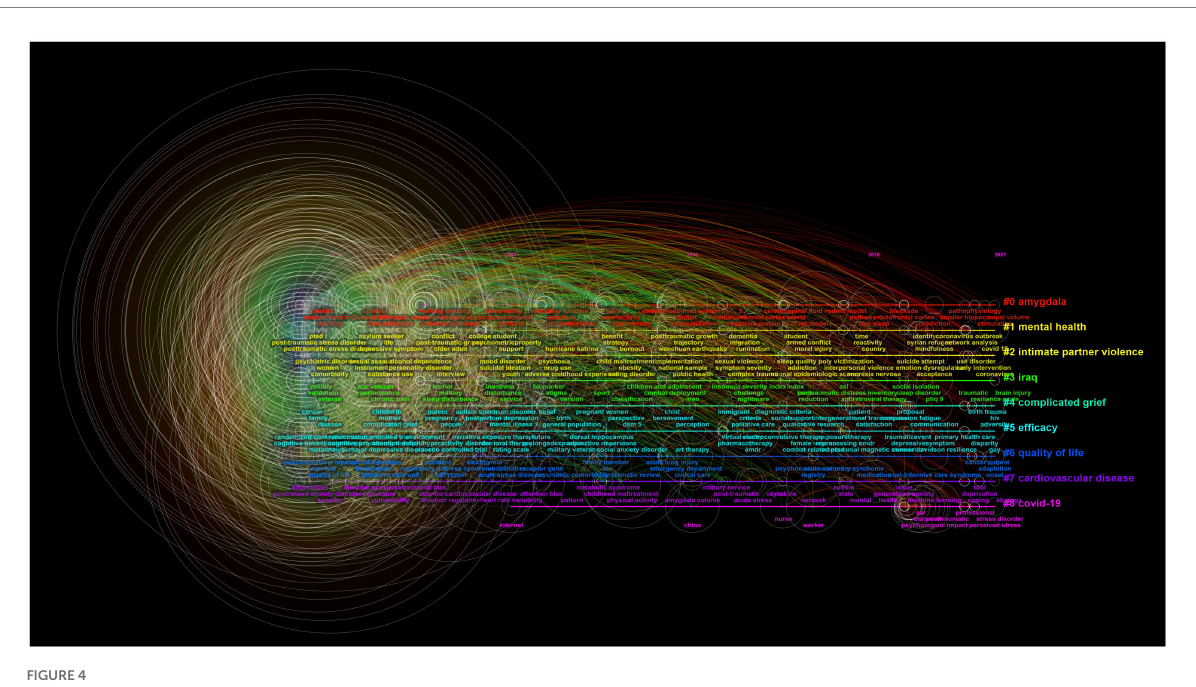
FIGURE 4 Keyword cluster analysis time diagram. Lines of different colors represent different clusters of keywords, and the circles size represents the number of articles where the keyword